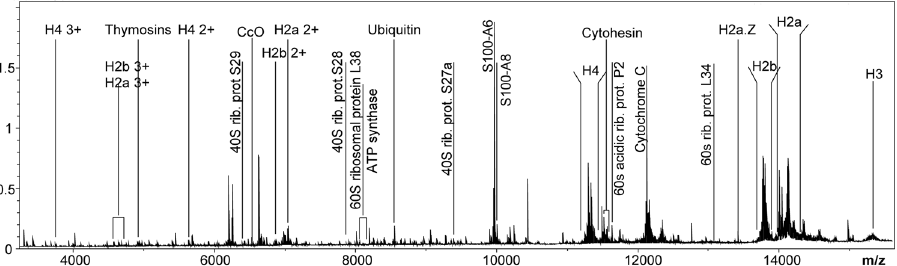
Figure 2. Average mass spectrum of a MALDI-FTICR MSI dataset of an entire mouse brain tissue section: annotation highlights most important and most abundant proteins identified with the support of the LCM- LC-MS/MS